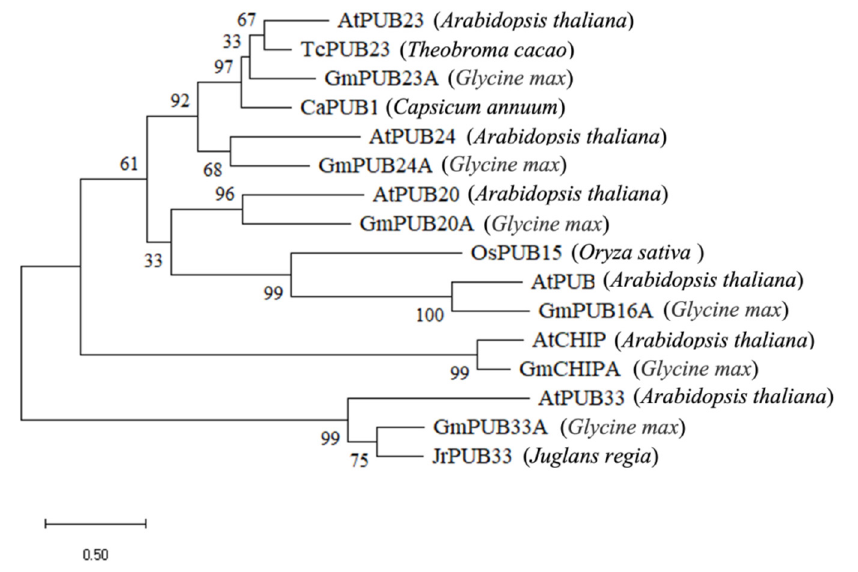
Figure 5. Phylogenetic analysis of six GmPUB proteins.